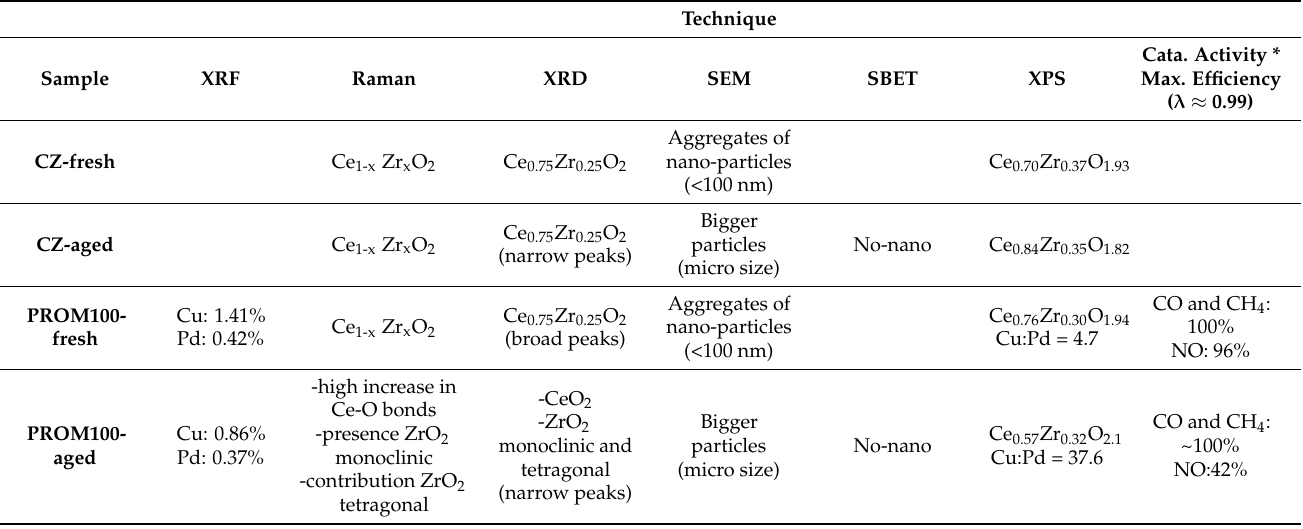
Table 5. Highlights from the different characterization methods used in this study and correlation with the catalytic